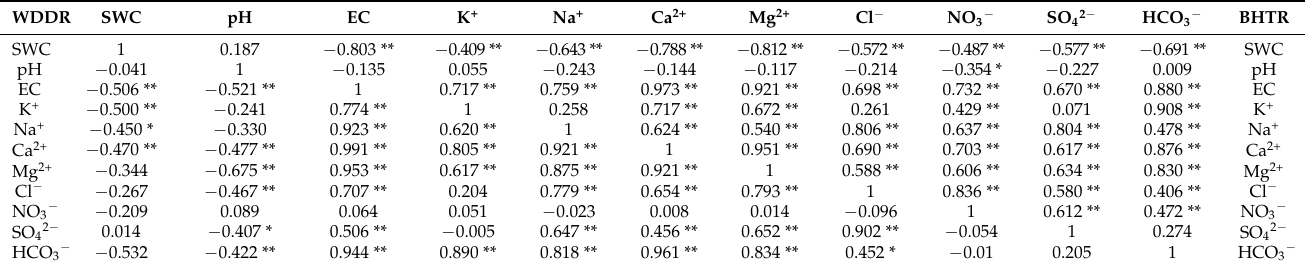
Table 2. Correlation coefficients between major components in soil-soluble salt in the study